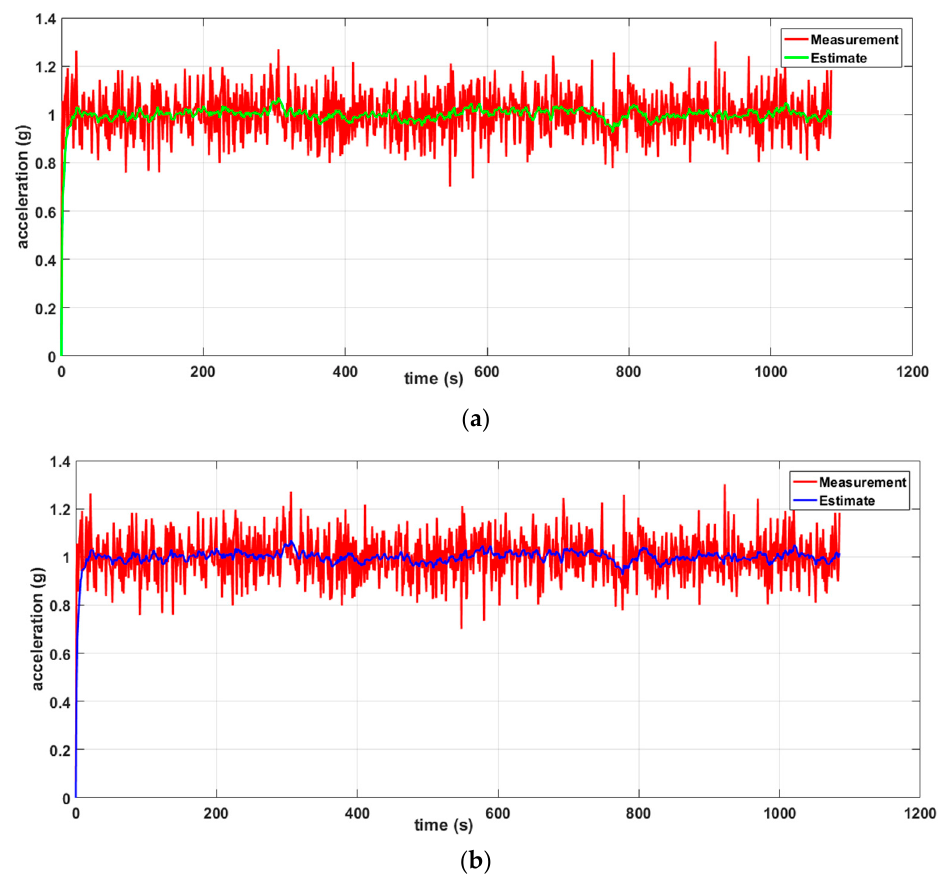
Figure 9. Results for distributed Kalman filter implementation with noisy measurements from both sensor nodes. ( a ) Sensor node S1. ( b ) Sensor node S2.